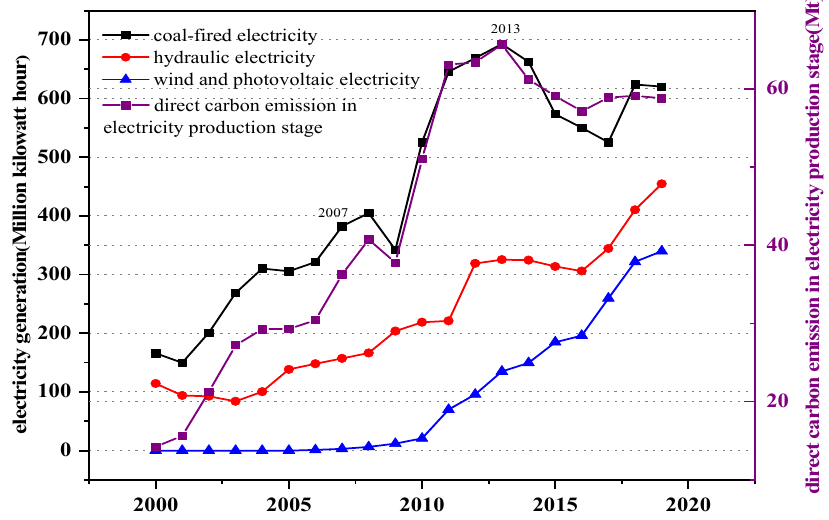
Figure 4. Power generation and carbon emissions from different power generation structures in Gansu Province during 2000–2019.